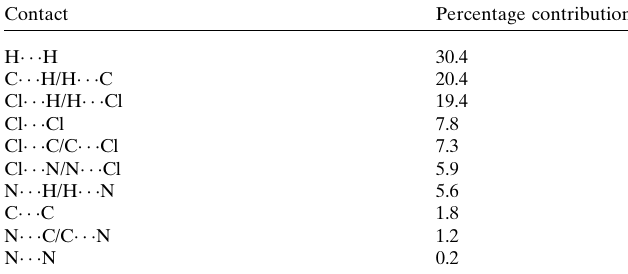
Table 2 Intermolecular contacts (A˚ ) in the title structure. Contact